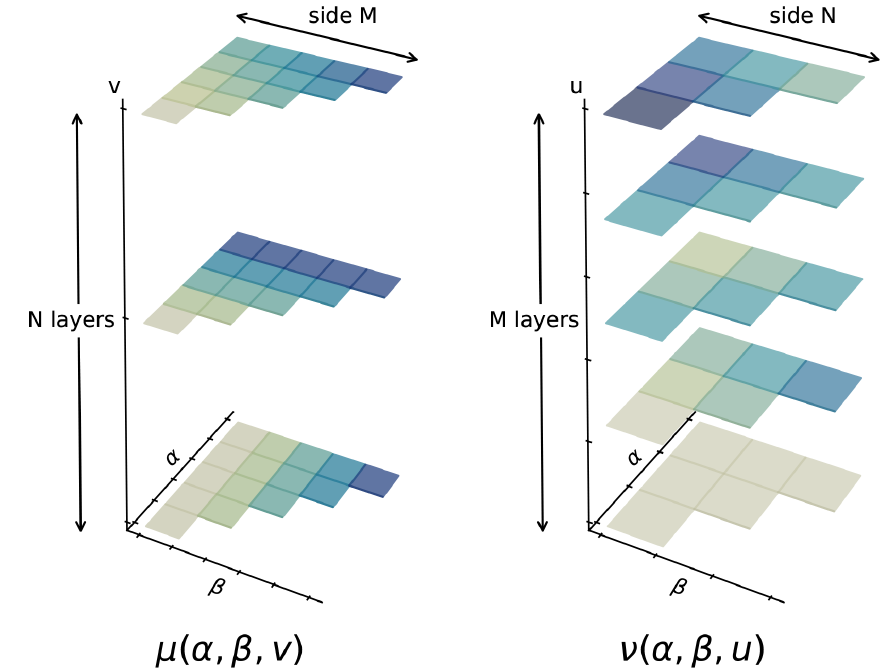
Figure C1. The discrete representation of the weight functions µ(α,β,v) and ν(α,β,u)